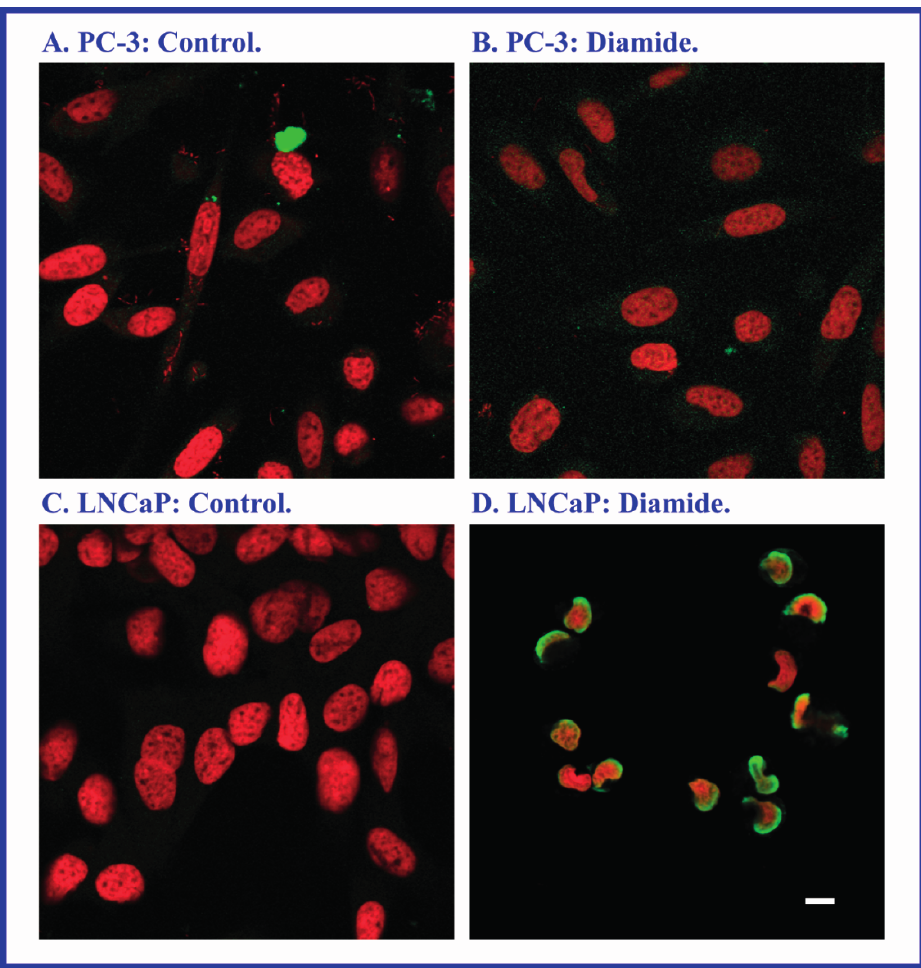
Figure 4. Sensitivity of PC-3 and LNCaP cells to diamide-induced apoptosis as assessed by the TUNEL assay. DNA fragmentation was assayed with the ApoBrdU TUNEL Assay Kit from Invitrogen (Carlsbad, CA, USA), using confocal microscopy. Cells were grown on 35 mm dishes. After incubation for 24 h with either media (=Control) or 250 µM